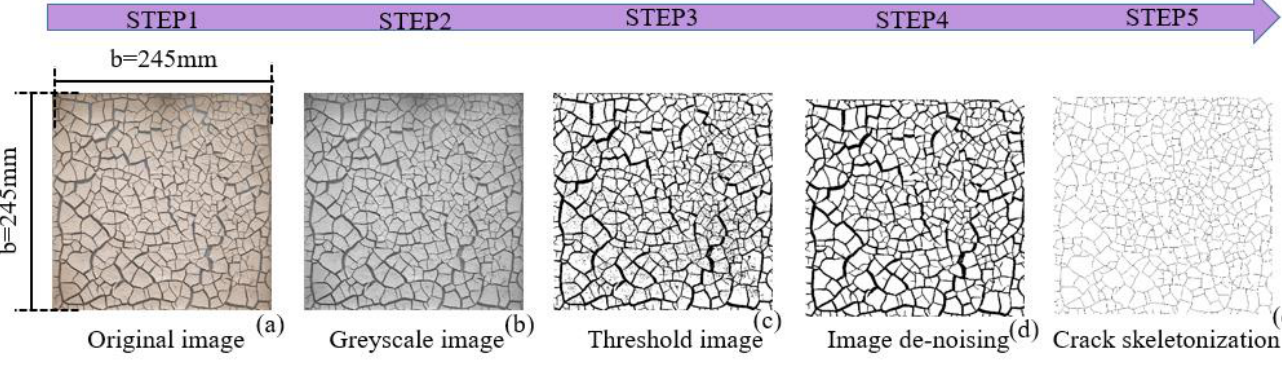
Figure 4. Image processing steps.